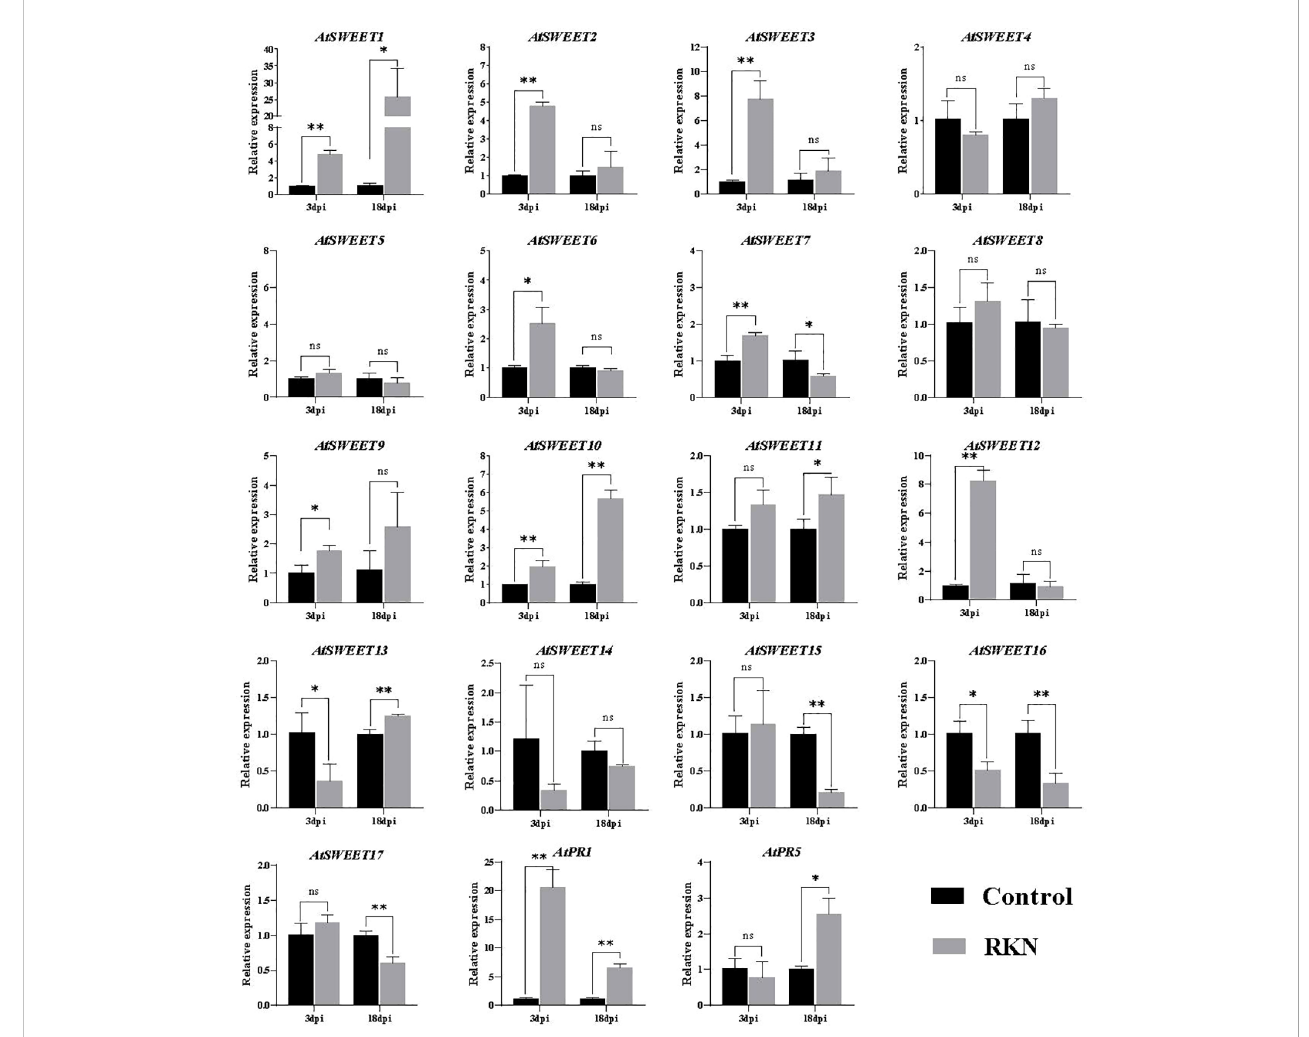
FIGURE 1 RKNs infection-dependent expression of AtSWEETs , AtPR1 , and AtPR5 in A. thaliana roots. Using noninoculated roots as control, expression levels of AtSWEETs , AtPR1 , and AtPR5 in A. thaliana roots inoculated with M. incognita at 3 dpi and 18 dpi were analyzed using quantitative reverse transcription PCR. Five biological replicates and three technical repeats were performed per sample. The Actin 8 gene was used as an internal control. Error bars indicate the SD between technical repeats (n=3). p-values were analyzed using student ’ s t-test (p*<0.05; p**<0.01). ns, no signi fi cant